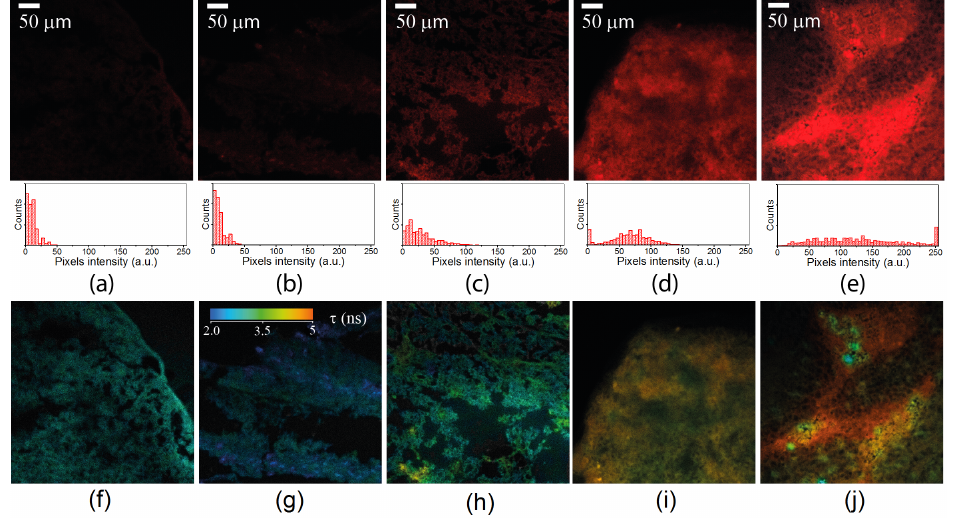
Figure 1. Typical fluorescence intensity images ( a – e ) and corresponding fluorescence lifetime images ( f – j ) recorded in the spectral range of 608–683 nm for the five samples: ( a , f ) control sample of the tumor tissue, ( b , g ) control sample of the testicular tissue, ( c , h ) photosensitized tumor tissue exposed to laser radiation prior to sample preparation, ( d , i ) photosensitized tumor tissue, and ( e , j ) photosensitized testicular tissue. Histograms of the intensity distributions in the fluorescence intensity images are shown below the images ( a – e ) for